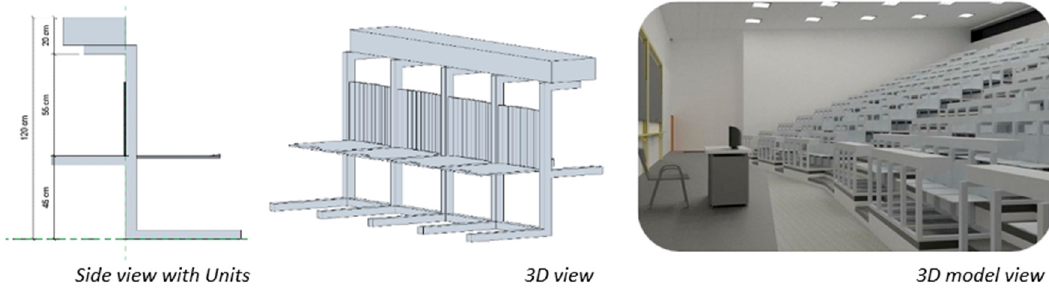
Figure 7. Desk object developed. Appl. Sci. 2020 , 10 , x FOR PEER REVIEW